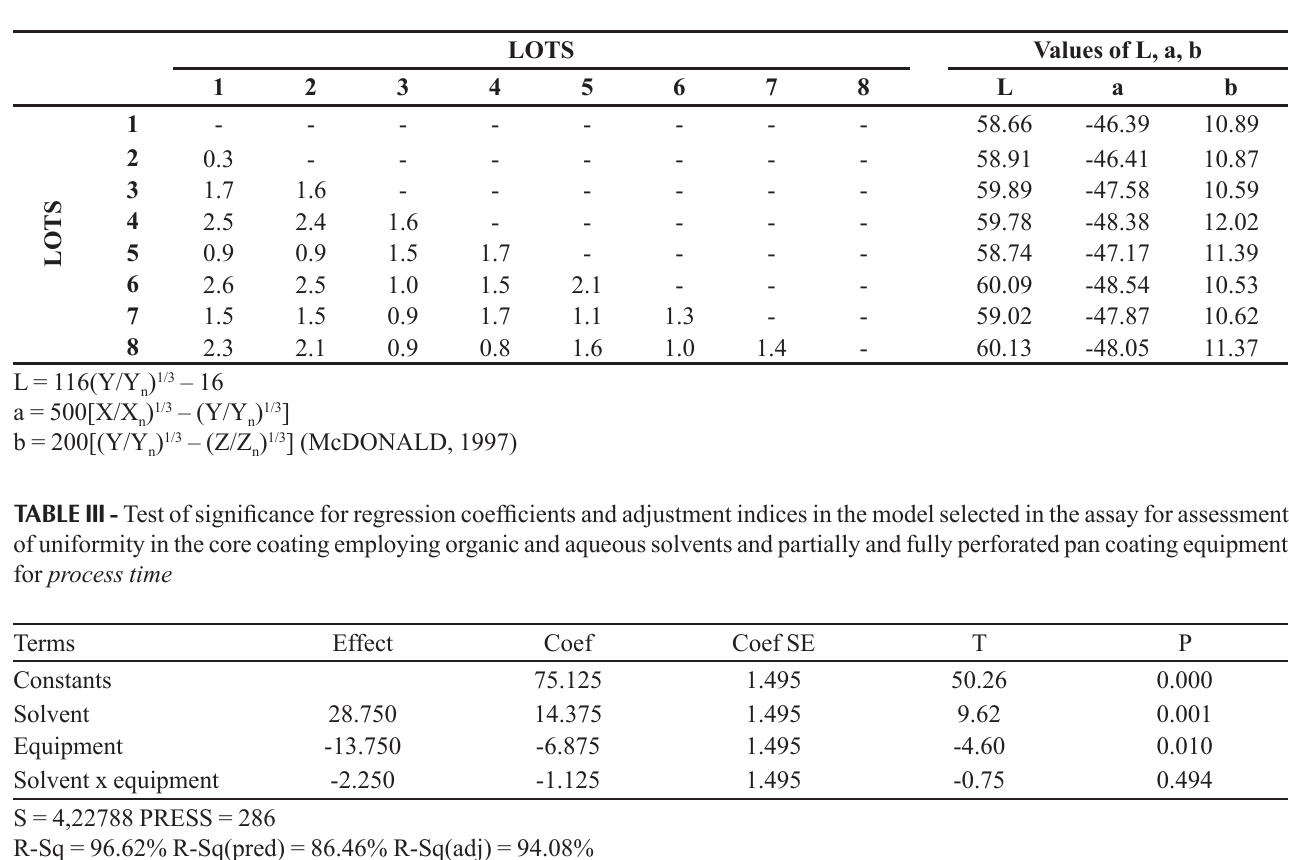
TABLE II - Values L, a, b in the assay for assessment of colour uniformity in the core coating step, employing partially and fully perforated pan coating equipment, at the end of each assay, and values of ΔE between pairs out of the eight lots of coated tablets produced